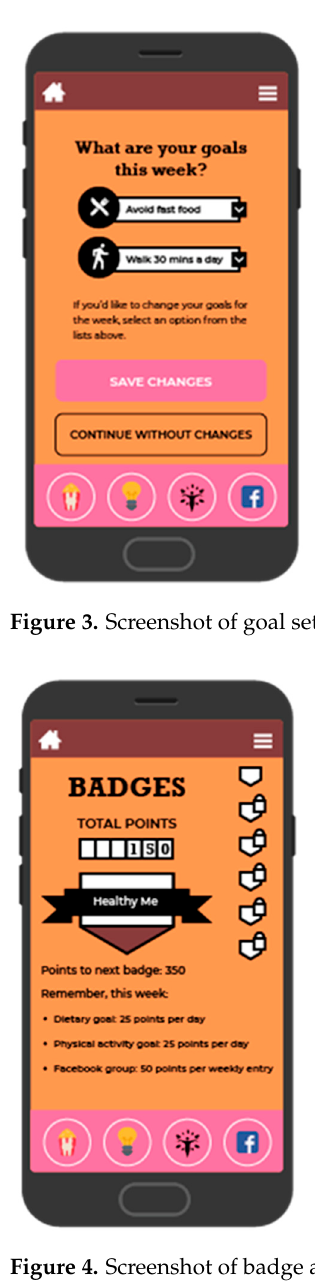
Figure 2. Screenshot of weight tracking and feedback.